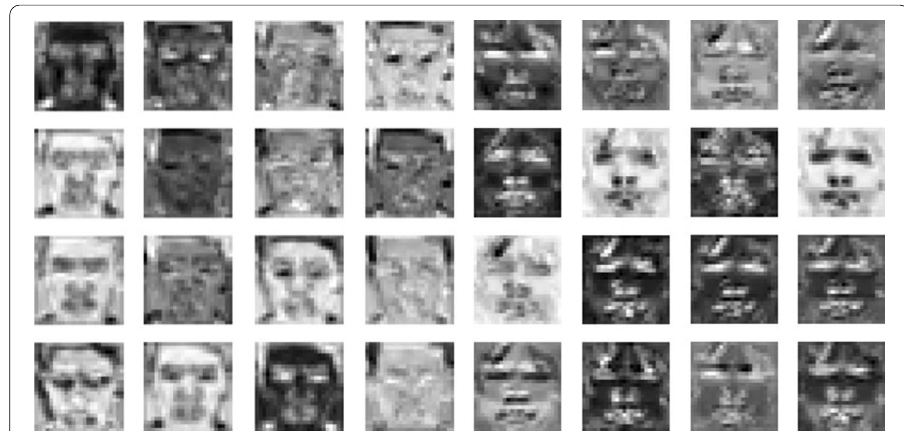
Fig. 4 Conv2D activation filters visualisation of